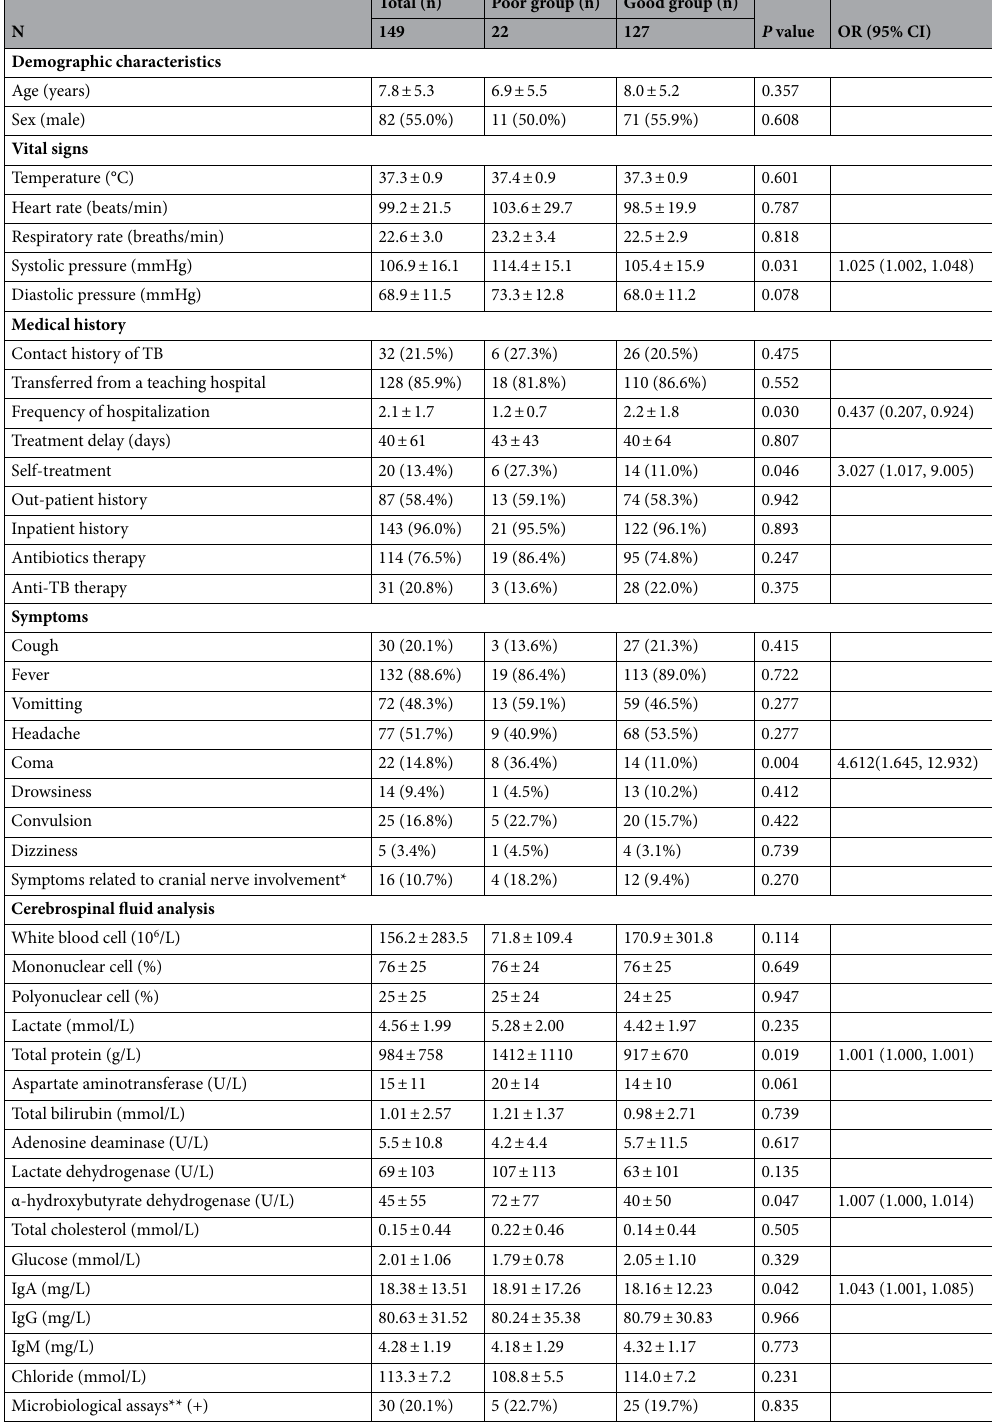
Table 1. Univariate analysis of the demographic data associated with poor outcome in childhood tuberculous meningitis. TB , tuberculosis, OR , odds ratio, CI confidence interval. *Symptoms related to cranial nerve involvement include motor abnormalitie, speech difficulties, swallowing difficulties, and visual loss. **Microbiological assays include CSF AFB smear, CSF PCR, CSF Xpert, and CSF culture (“ + ” means at least 1 assay